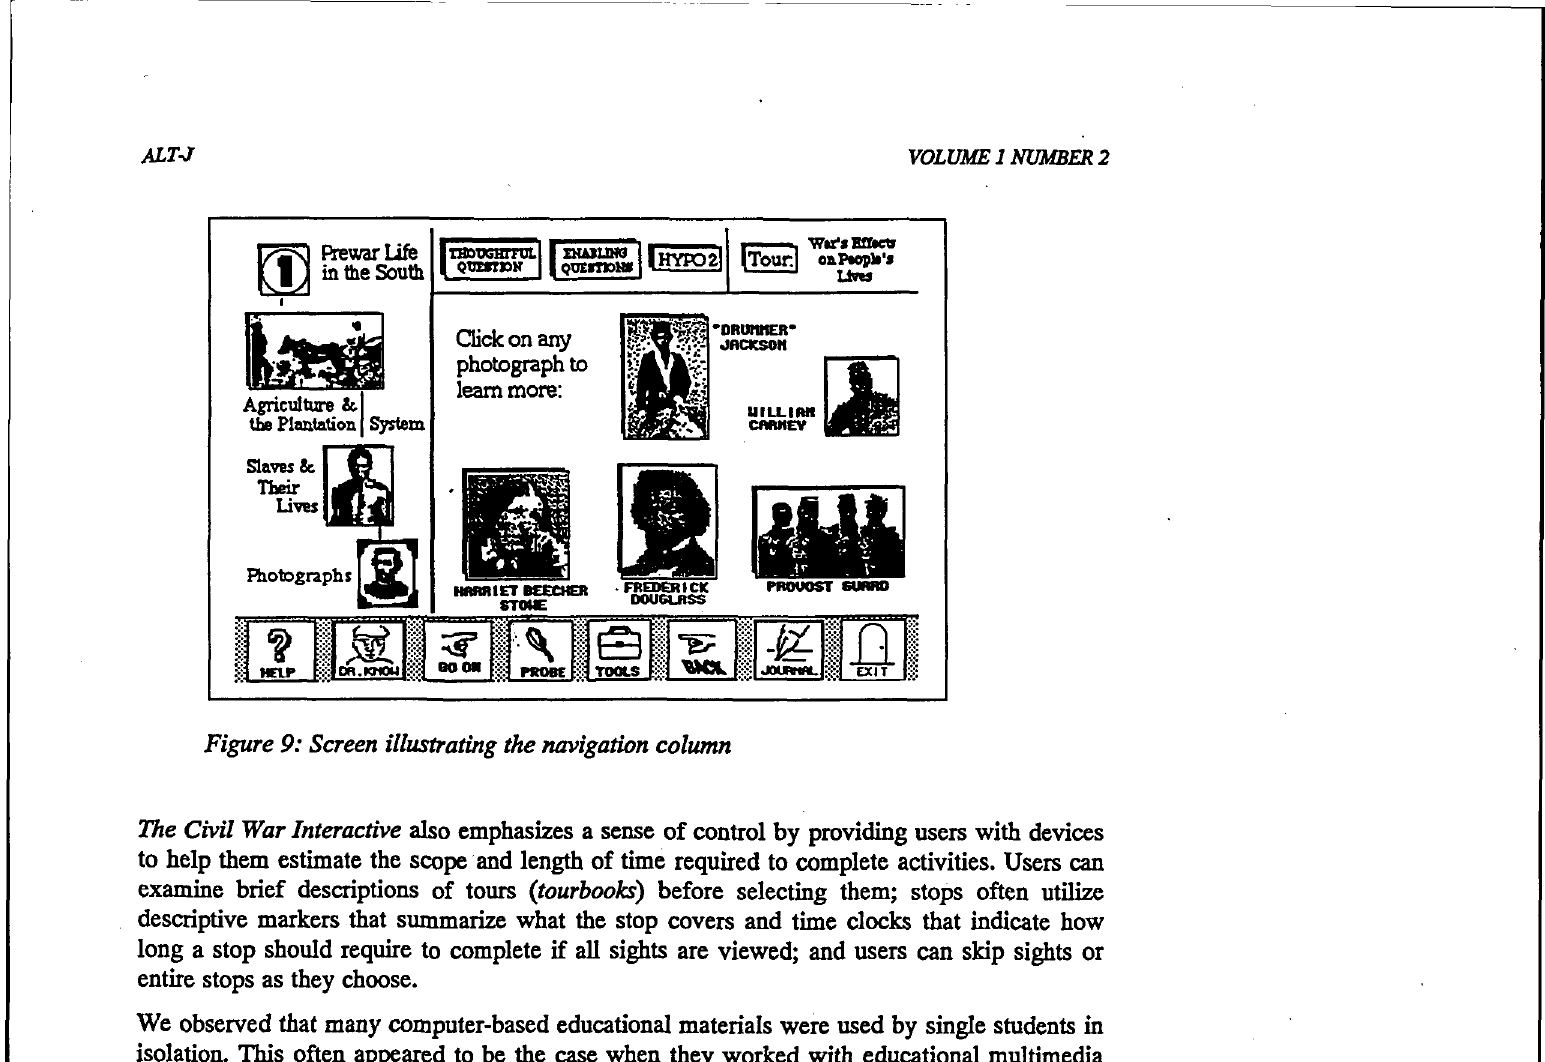
Figure 9: Screen illustrating the navigation